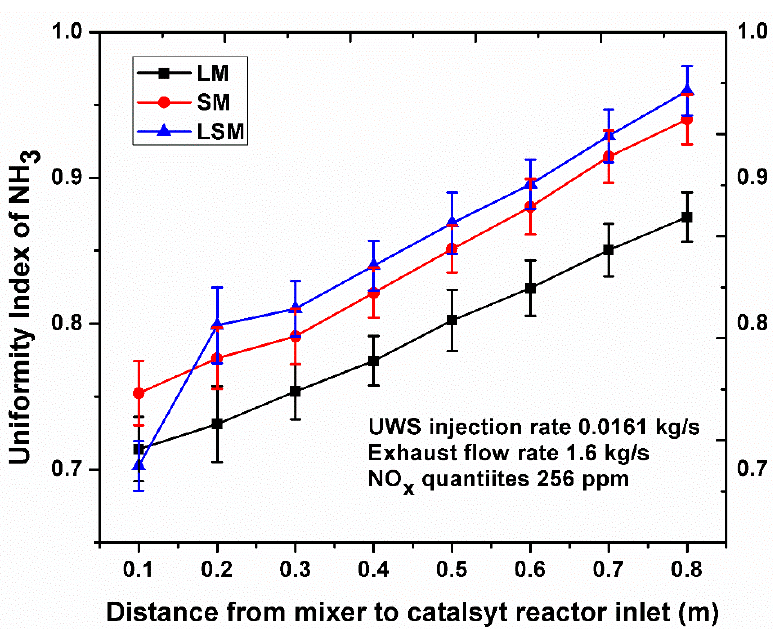
Figure 7. Distribution of ammonia uniformity.